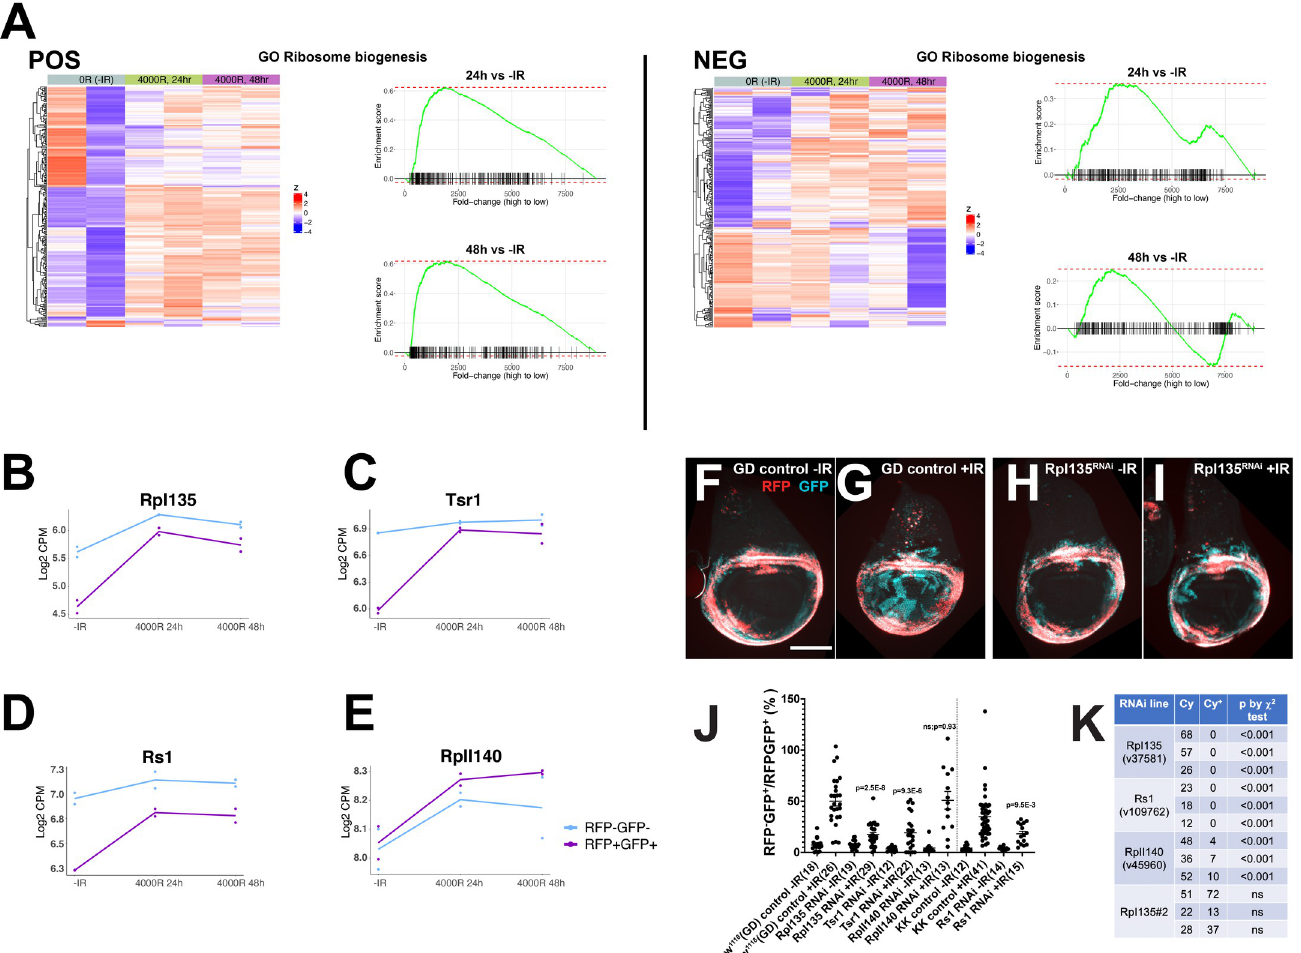
Fig 5. Depletion of ribosome biogenesis factors inhibits the regenerative behavior of hinge cells. (A) Heatmap displaying genes in ribosome biogenesis in POS and NEG cells. Gene names are in S2 Table. Gene set enrichment plots for indicated differential expression comparisons are shown to the side. The fold-change is ranked from high to low, so higher in 24h or 48h compared to -IR. (B-E) Expression trajectory of three ribosome biogenesis genes, RpI135, Rs1 and Tsr1, illustrate how their expression increased to a greater extent in POS cells than in NEG cells after IR. RpII140, encoding a subunit of RNA pol II, is shown here as a counter- example of a gene that does not show this trajectory. Pairs of dots represent data from two biological replicates. Lines connect the averages. (F-I) Wing discs from control larvae with matched background (GD) and larvae expressing RNAi for RpI135 in the hinge, treated as shown in Fig 1G. Controls show robust cell fate change and translocation after IR (G) but RpI135 depletion in the hinge inhibited IR-induced cell fate plasticity (I). Scale bar = 100 microns. (J) Discs such as those shown in (F-I) were quantified for total RFP - GFP + area in the pouch area as in Fig 4 and normalized to the RFP + GFP + hinge area to account for variations in disc size. Cell autonomous depletion of RpI135, Rs1 and Tsr1 significantly decreased the normalized RFP - GFP + area. P values are for comparison to GD+IR (2-tailed t- test). The numbers in brackets are the total number of discs examined in two or more biological replicate experiments. (K) The potency of RNAi constructs was assessed in terms of lethality when constitutively expressed (without GAL80 ts ) from en-GAL4, using the X 2 test. One parent in each cross was balanced over CyO so that expected ratio if RNAi had no effect was 1 Cy:1Cy + . RpI135 (v37581), Rs1 and RpII140 displayed effective RNAi by this measure. The RpI135 RNAi construct #2 did not affect survival and, likewise, did not affect cell fate plasticity (S3 Fig). The data from three independent egg collections for each RNAi line are